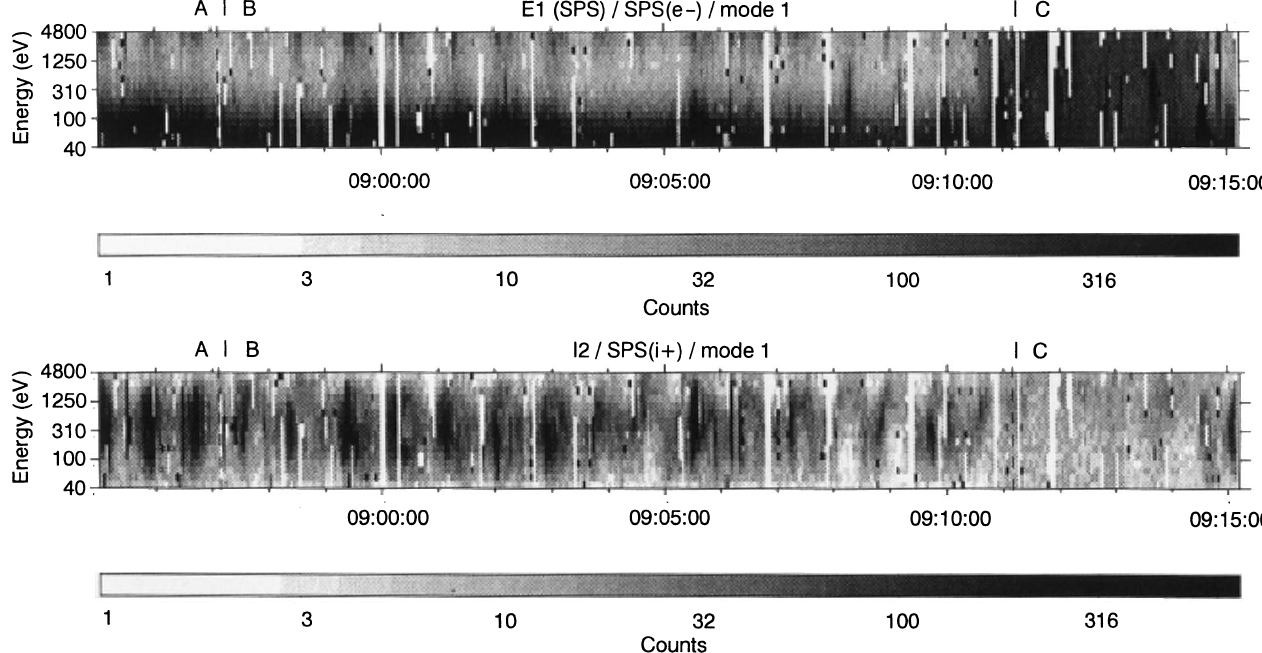
maximum count rate are shown. Grey scales are in counts, the counting time was 150 ms for each